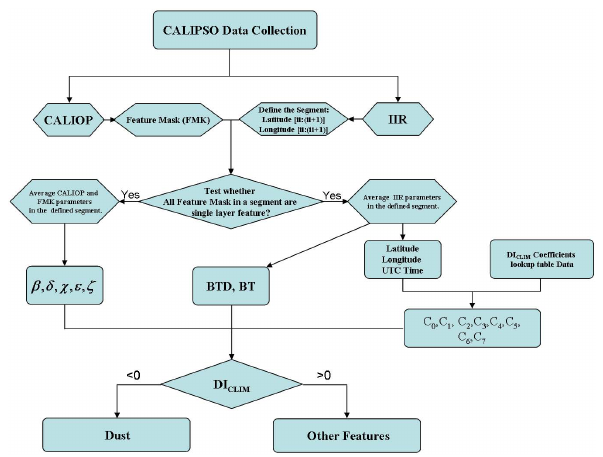
Fig. 5. CLIM method dust aerosol detection flow chart for a seg-